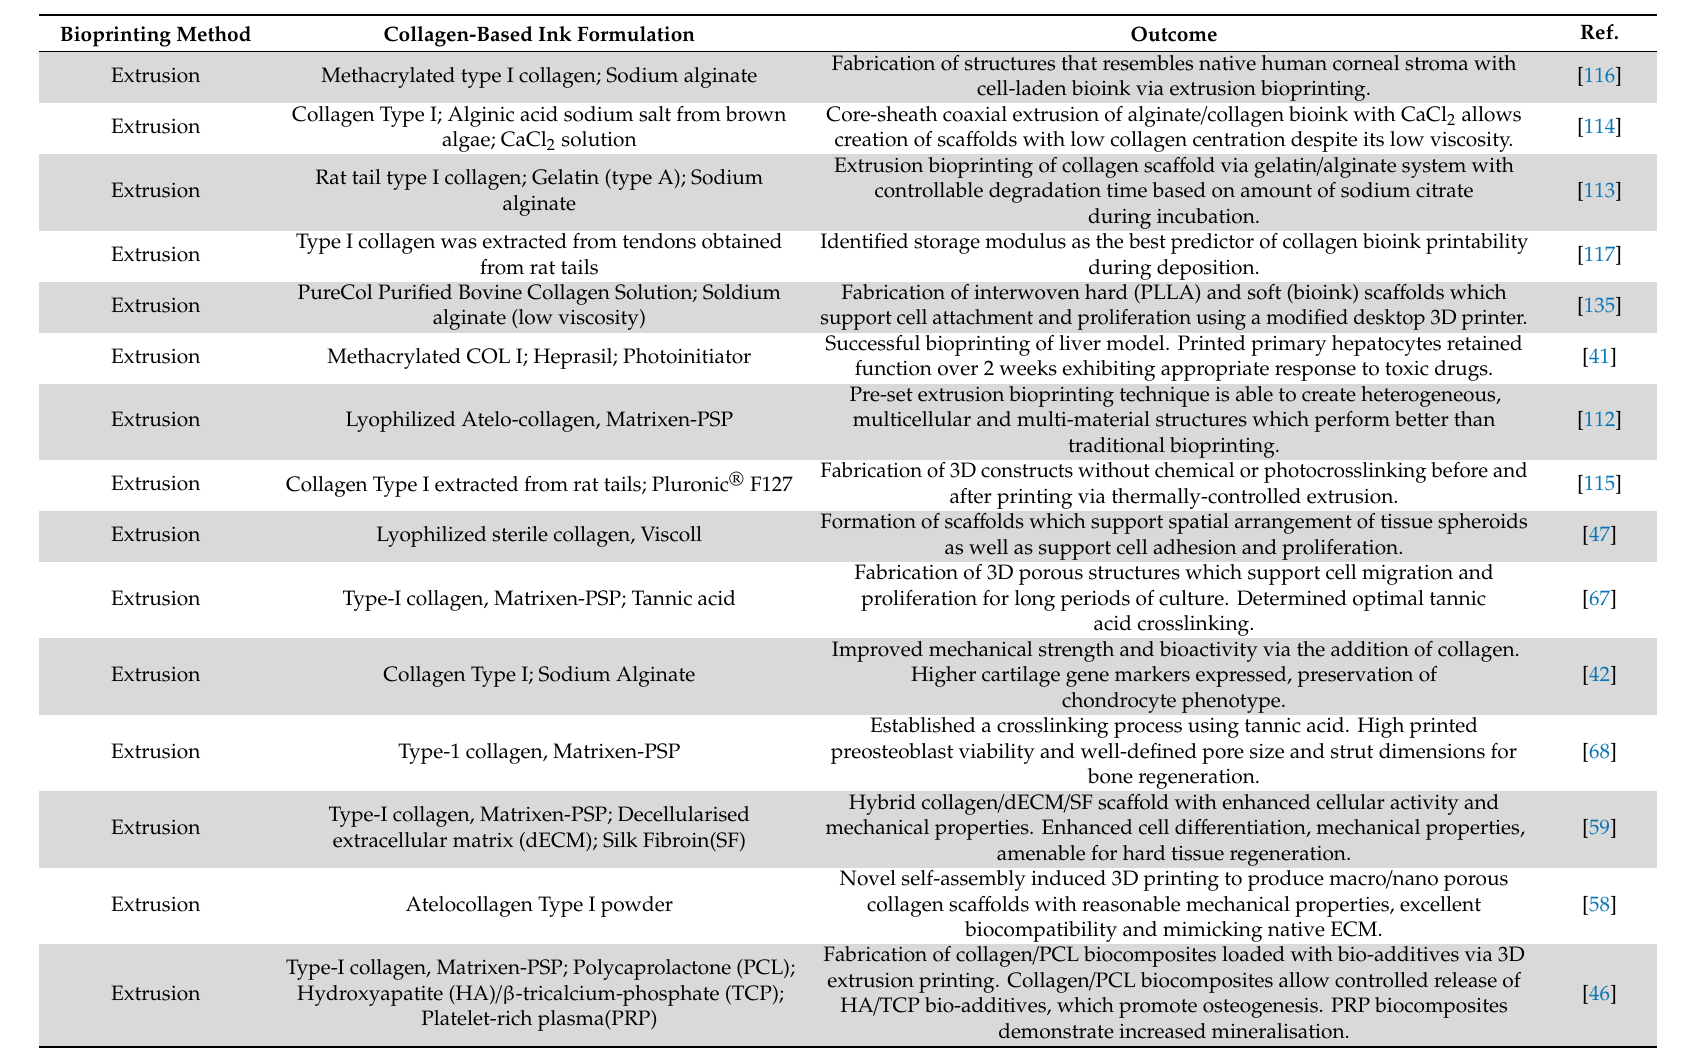
Table 1. Applications of additive bioprinting methods for collagen-based